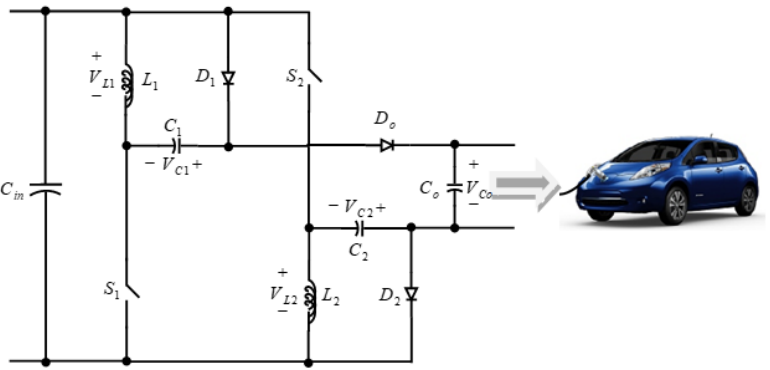
Figure 1. The proposed topology for the boost dc-dc converter.